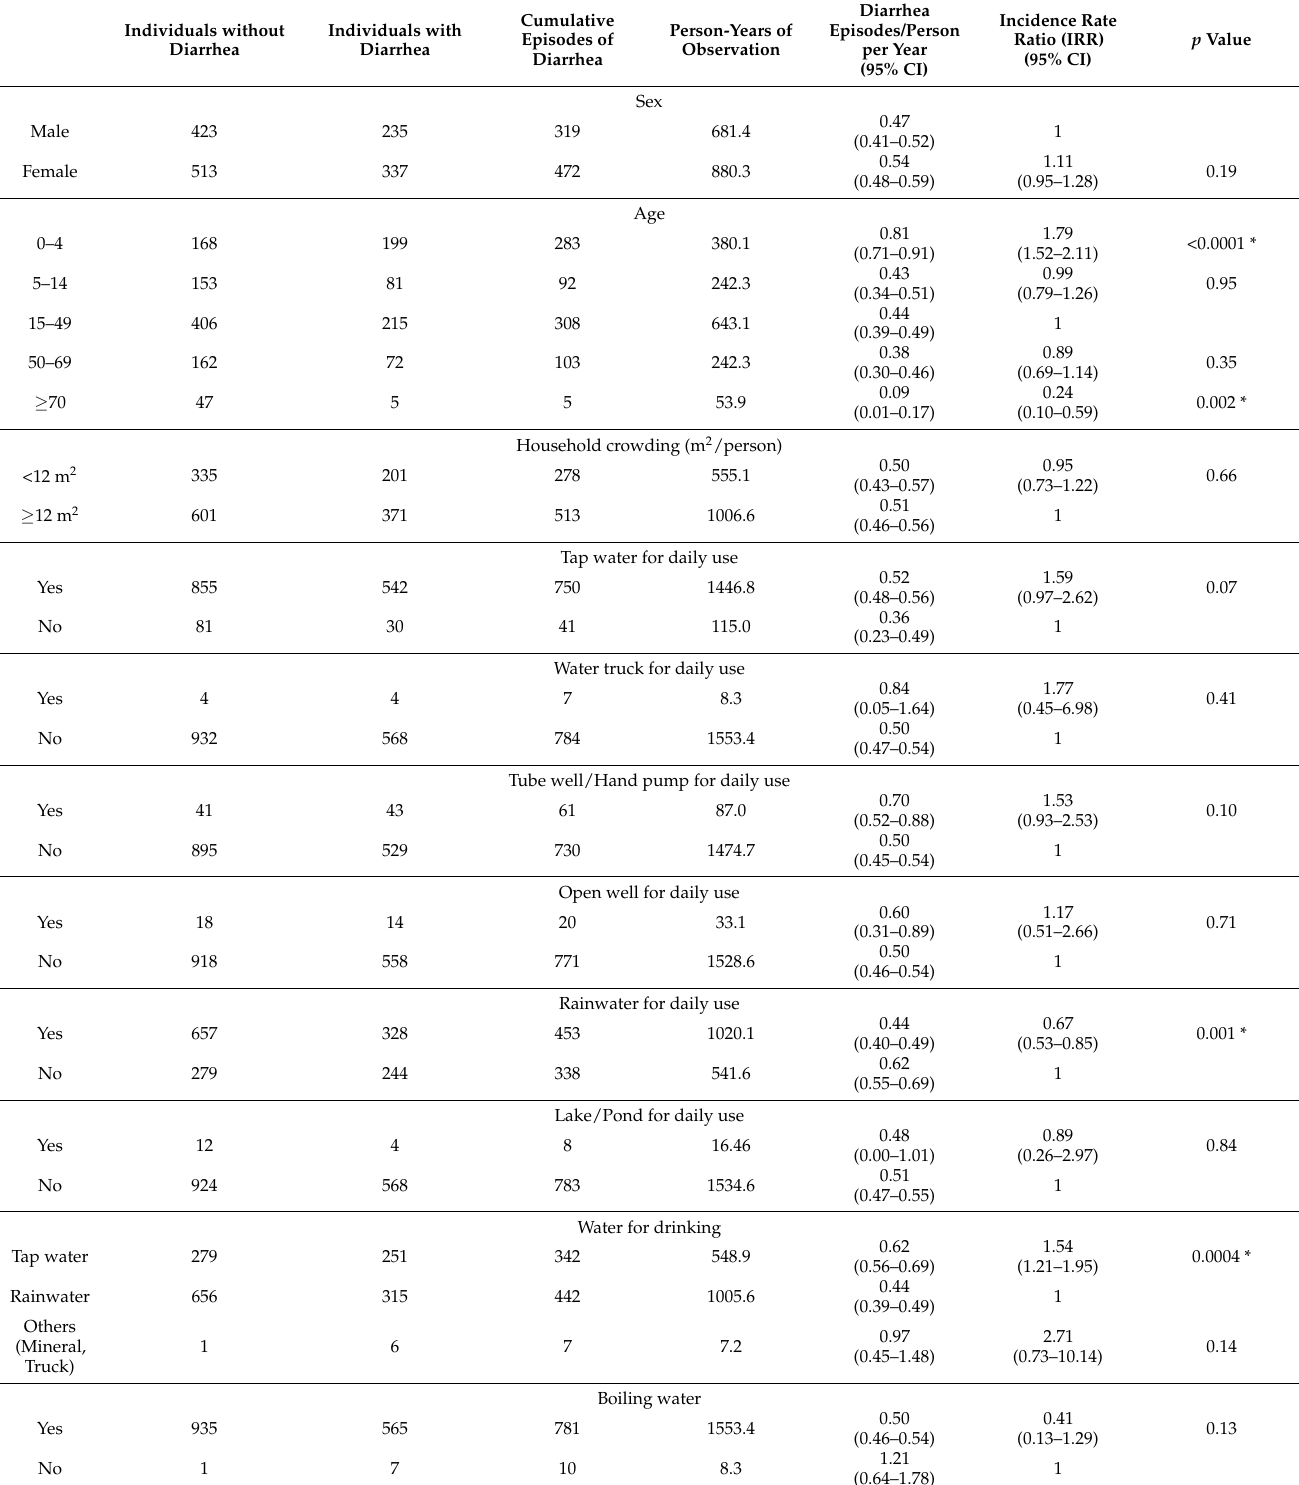
Table 2. Univariate NB-GLMM of risk factors using the data in this study period (54 weeks). “House- hold” was included as a random